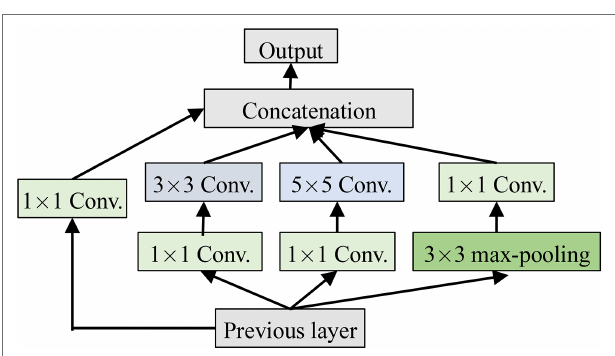
FIGURE 3 | The structure of